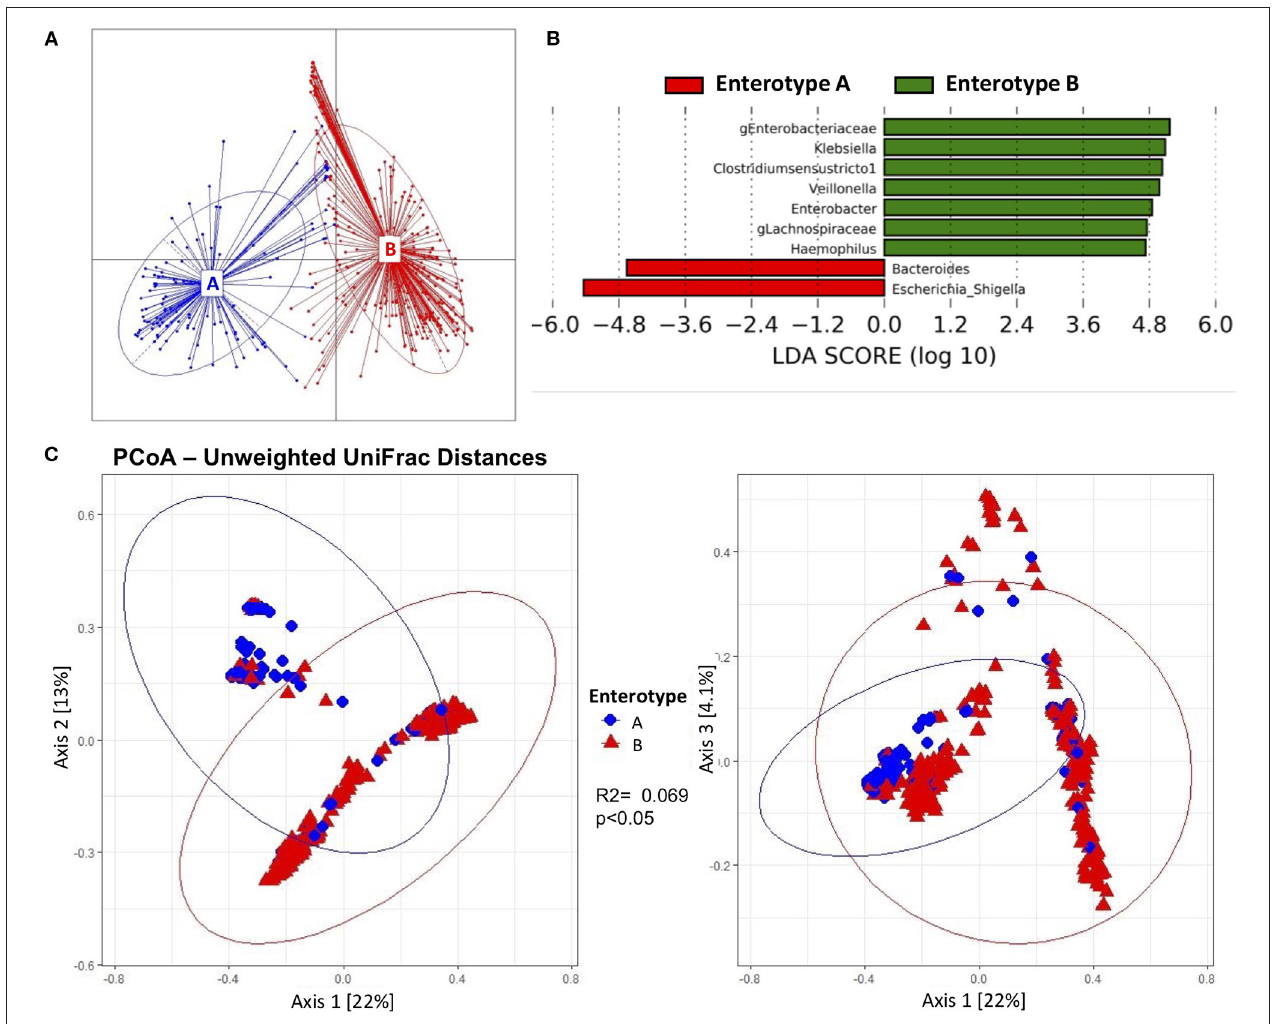
FIGURE 3 | Beta diversity and enterotypes characteristics of gut microbiota from preterm infants. Beta diversity was significantly associated to two different enterotypes. (A) Two different enterotypes (Enterotype A and Enterotype B) were characterized. The majority of the samples belonged to Enterotype B. (B) Discriminative genera determined by linear discriminant analysis (LDA) showed bacteria that Bacteroides and Escherichia-Shigella were enriched in Enterotype A; whereas uncharacterized Enterobacteriaceae , Klebsiella , Clostridium sensu stricto 1 , Veillonella , Enterobacter , uncharacterized Lachnospiraceae and Haemopohilus were enriched in Enterotype B. (C) Principal coordinate representation of Unweighted UniFrac Distances (Axis 1 vs. Axis 2, and Axis 1 vs. Axis 3) of the two enterotypes. Enterotypes explained 6.9% of the variance of the Unweighted UniFrac